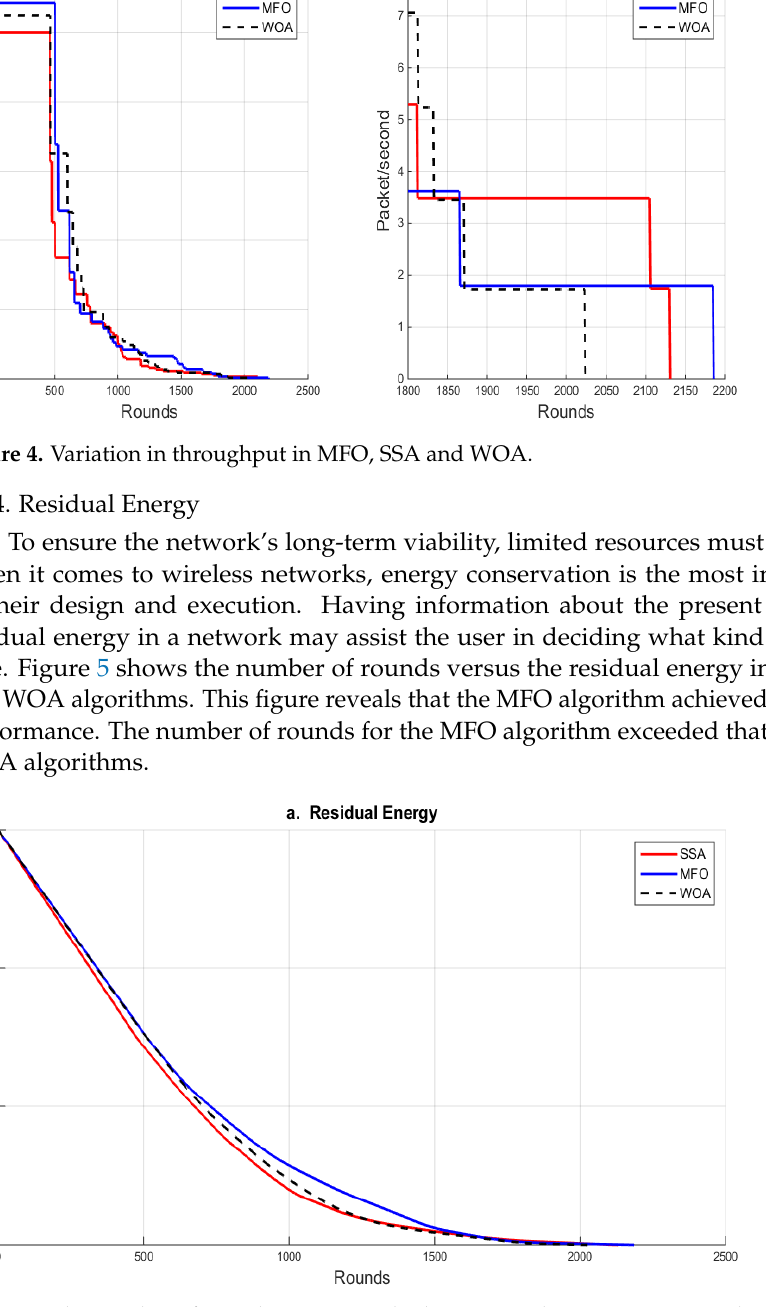
Figure 6. The number of rounds versus fitness function within WOA, MFO and SSA.